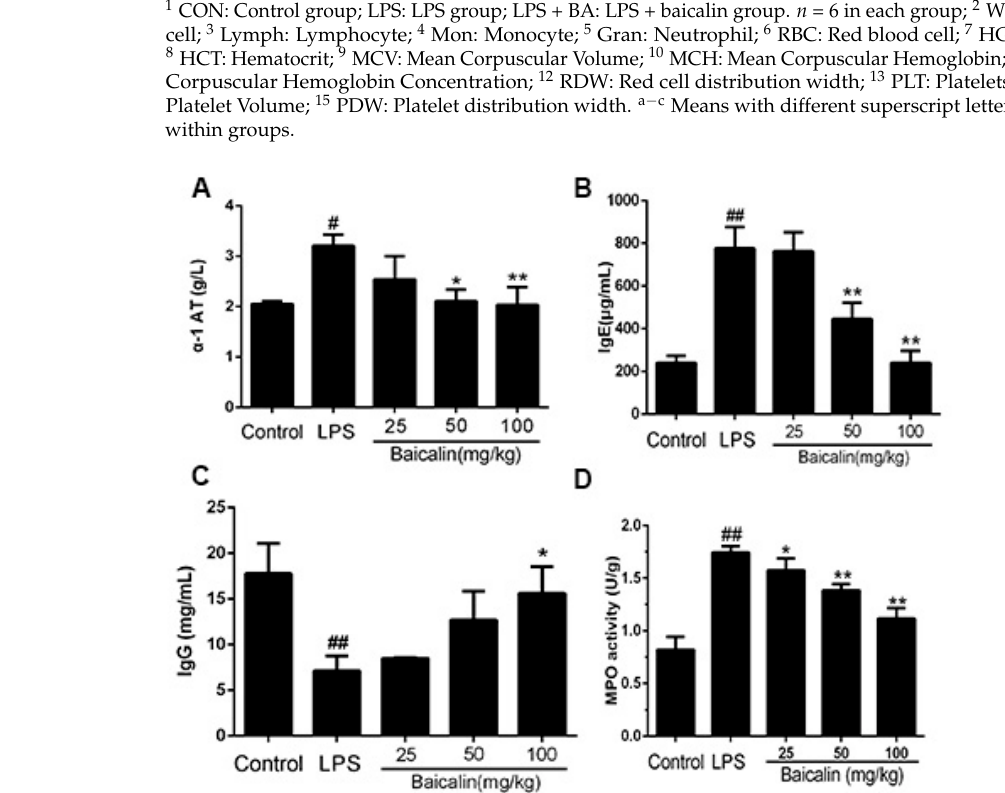
Figure 6. Effect of baicalin on the contents of α -1 AT, IgE, IgG, and MPO in LPS-induced ALI mice. LPS + baicalin group mice ( n = 6 per group) were given an intraperitoneal injection of baicalin (25, 50, and 100 mg/kg) 1 h prior to LPS administration. After 12 h, the blood was collected. ( A ) α -1 AT content of each group; ( B ) IgE content of each group; ( C ) IgG content of each group; ( D ) MPO activities of each group. The values presented are the means ± SEM ( n = 6 in each group). # p < 0.05 vs. control group; ## p < 0.01 vs. control group; * p < 0.05 vs. LPS; ** p < 0.01 vs. LPS.